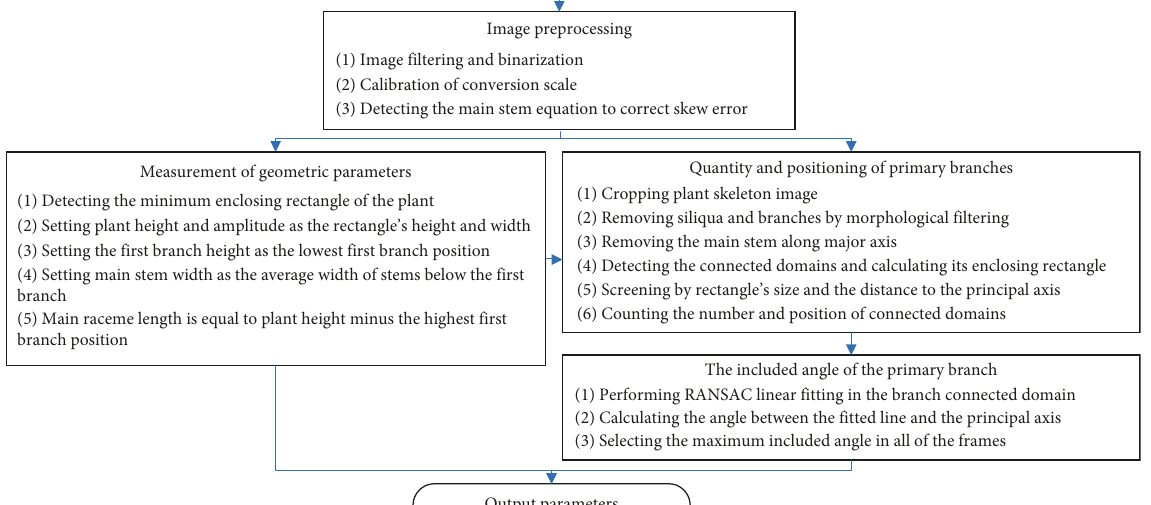
Figure 3: Algorithm